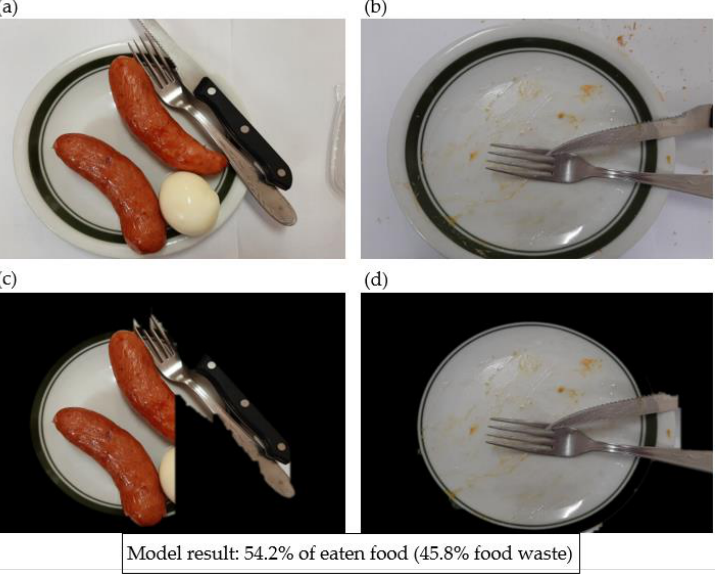
Figure 7. The model deficiency due to the color and shape of the plate; ( a ) before the meal, ( b ) after the meal, ( c ) before the meal and masked and ( d ) after the meal and masked. The last deficiency of the proposed model is detected when the cutlery is part of the plate in the image before the meal, and when, after the meal, the cutlery is positioned in the middle of the plate. In this case, the cutlery is detected as part of the food before meal and the food waste in the images after the meal. Observing Figure 8a,b, with common sense, it can be concluded that there is 0% food waste; however, the model recognized the cutlery as food, and the model produced false result of 45.8% of food waste.